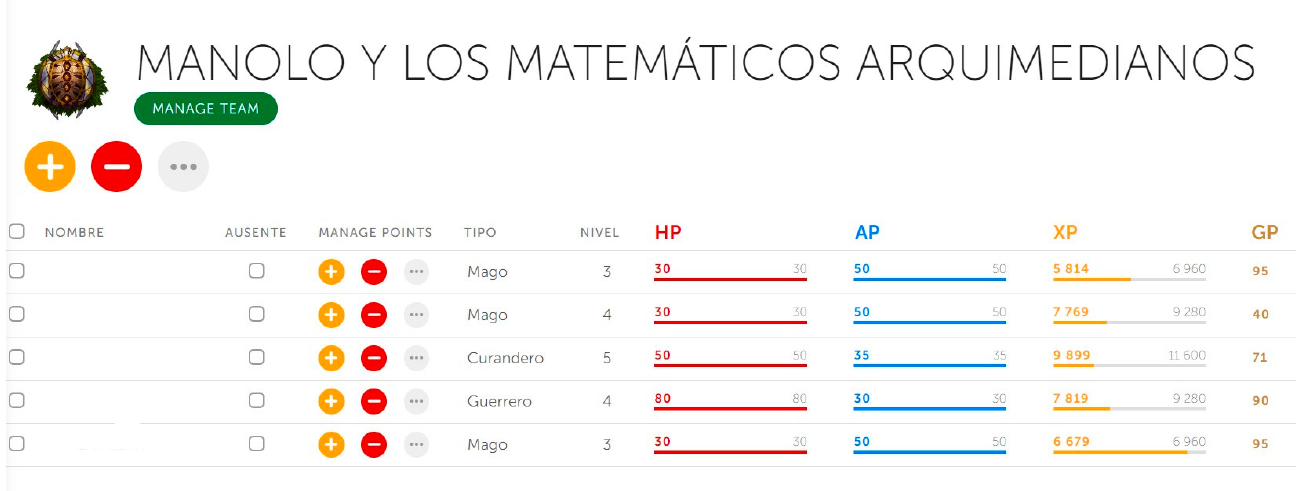
Figure 20. Team score data or leader board in Classcraft.